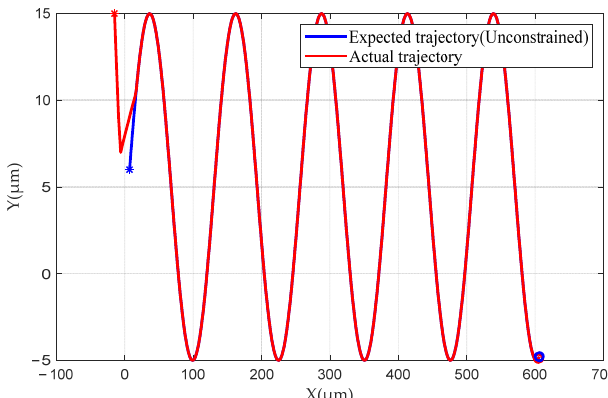
Figure 5. Single-cell manipulation control trajectory using NSOFCMNN.